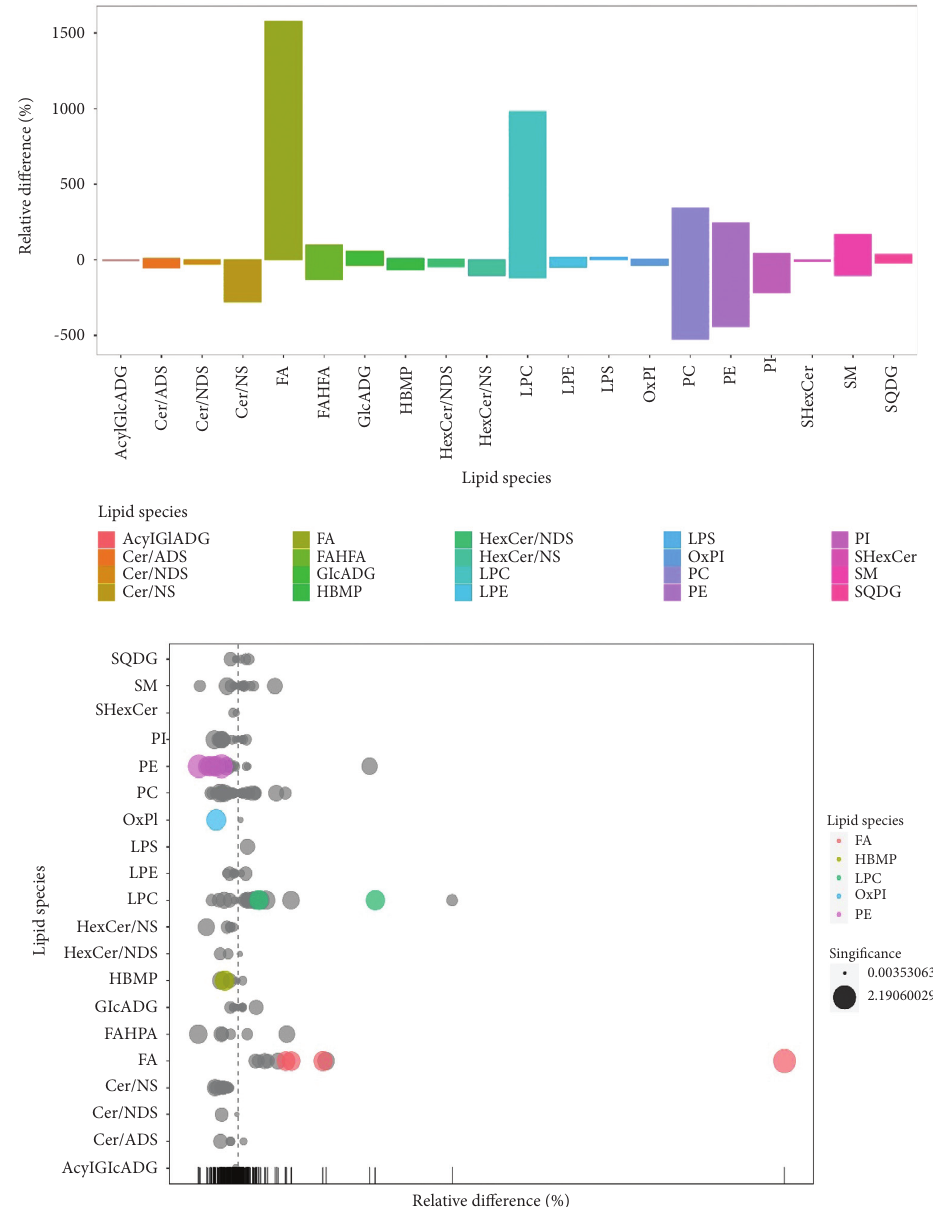
Figure 8: Histogram and bubble plot of lipid group in high-fat feed-ordinary rice group (negative ion